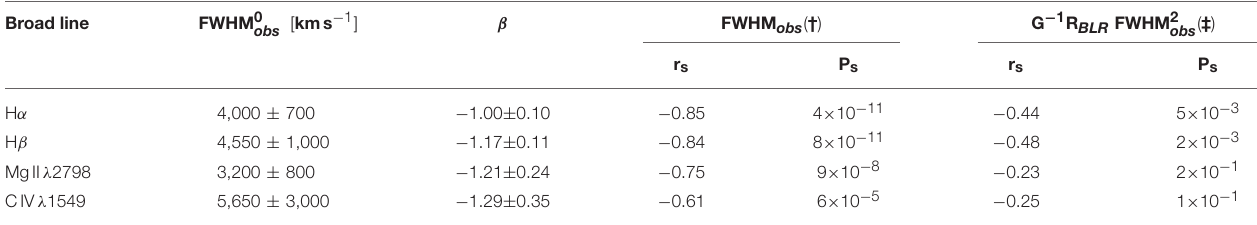
β . r s and P s are the Spearman correlation coefficient and associated null-hypothesis probability